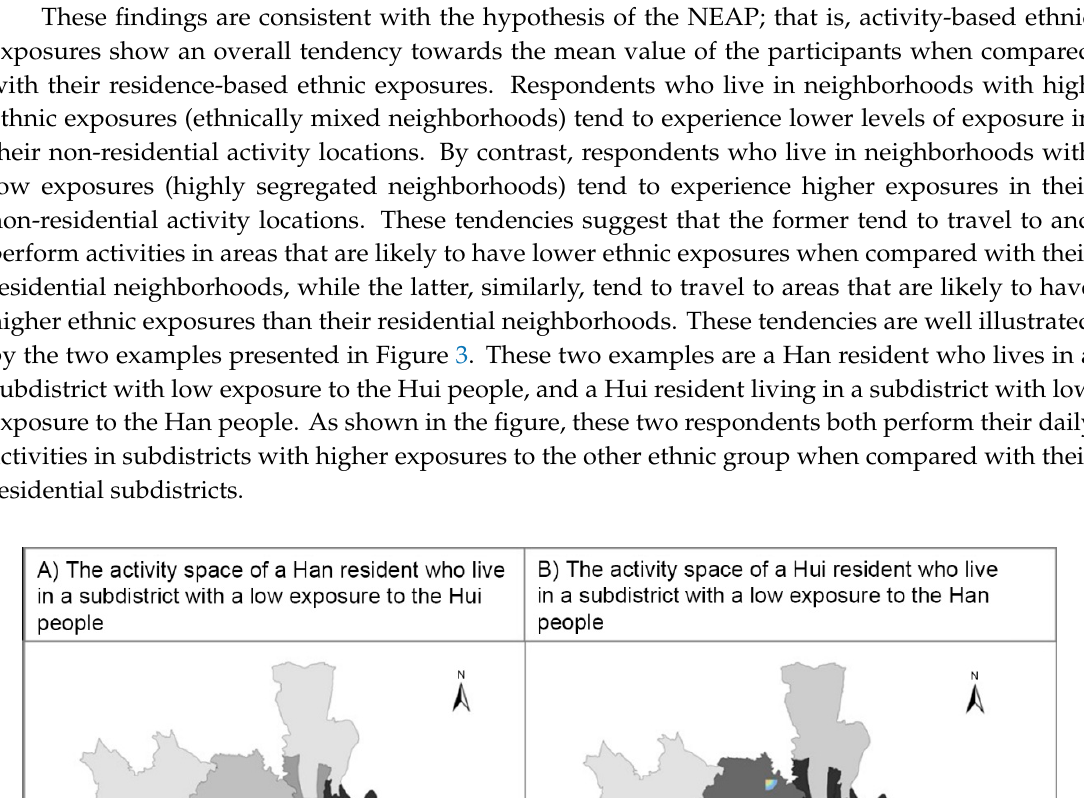
Table 3. Analysis of variance (ANOVA) for the overall deviation index ( D ).